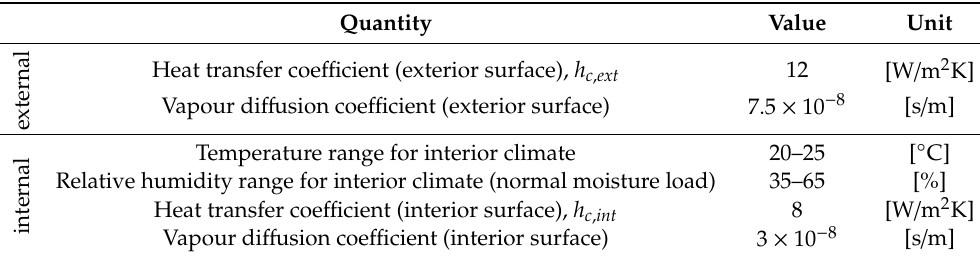
Table 1. Relevant parameters and coefficients used for the hygrothermal simulations, for external and internal boundary conditions.